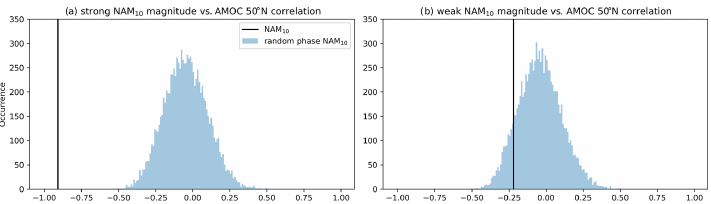
Figure A3. Probability distribution functions (PDFs) for correlations between the magnitude of NAM 10 extreme positive (a) and negative (b) values from surrogate NAM 10 data and anomalies in the AMOC at 50 ◦ N evaluated 17 years later. Each NAM 10 surrogate is generated by applying a Fourier transform to the smoothed NAM 10 index, randomly shuffling the Fourier phases, and inverse transforming. Each PDF is built with 10000 surrogates, and the correlation between the NAM 10 extreme magnitude and 17-year lagged AMOC anomaly at 50 ◦ N is shown by vertical black lines in both